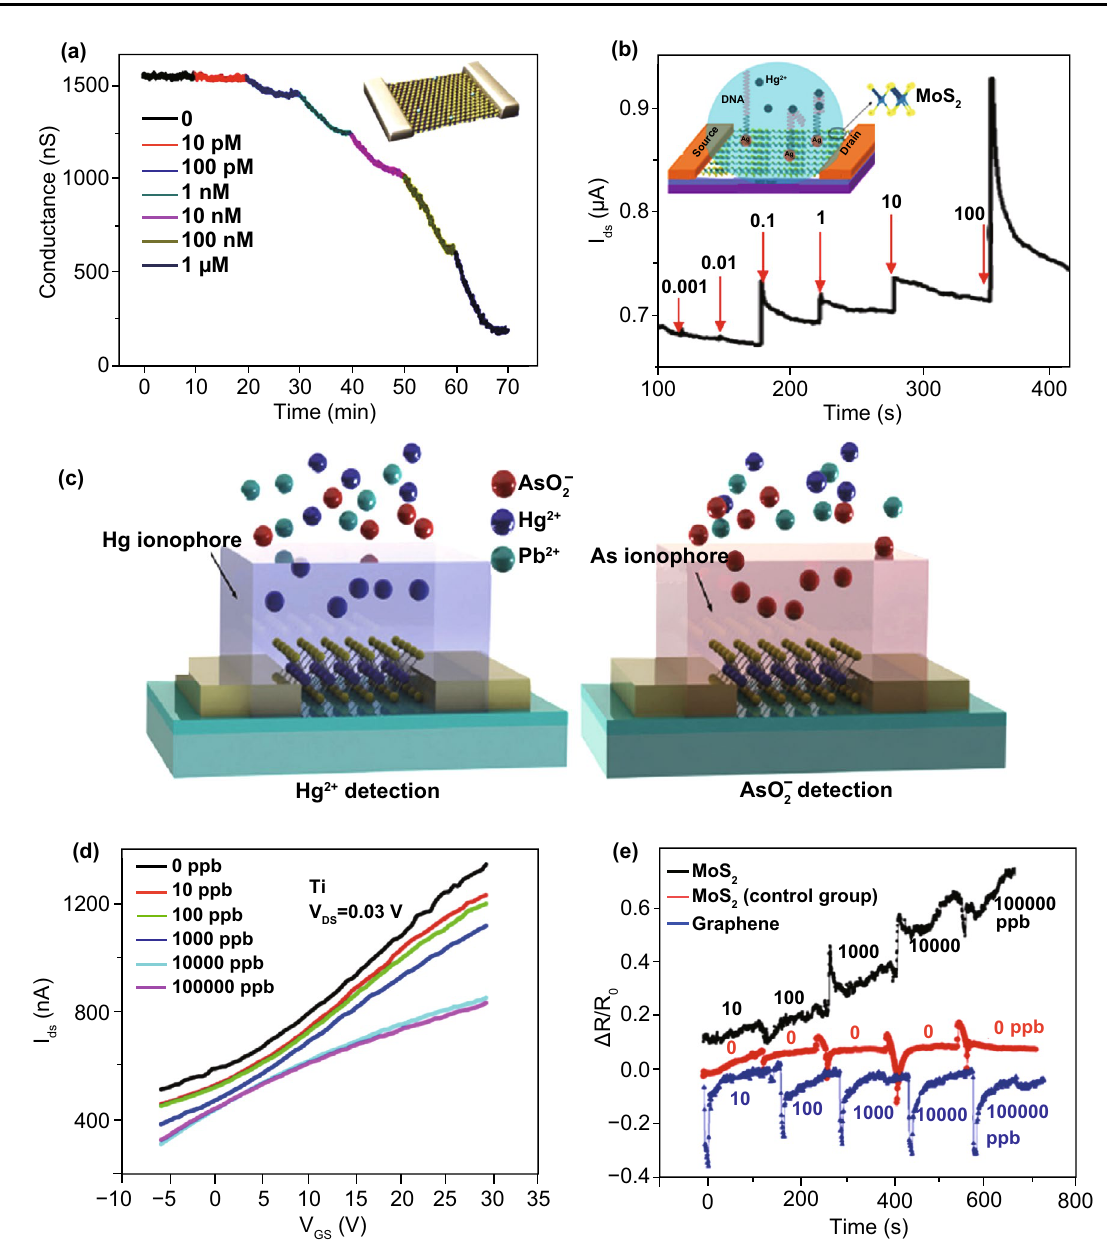
Fig. 6 2D TMDC FET ion sensors. a, b MoS 2 -based FET Hg 2+ sensors. Real-time conductance change signals of a bare MoS 2 and b DNA- functionalized